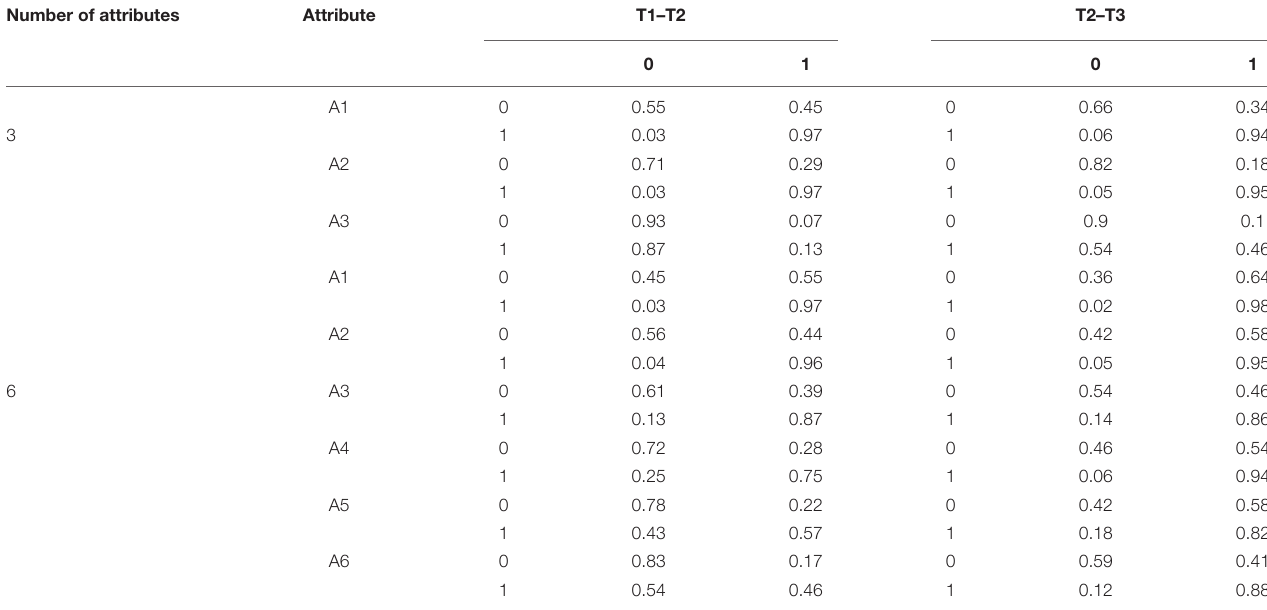
TABLE 2 | Conditional transition